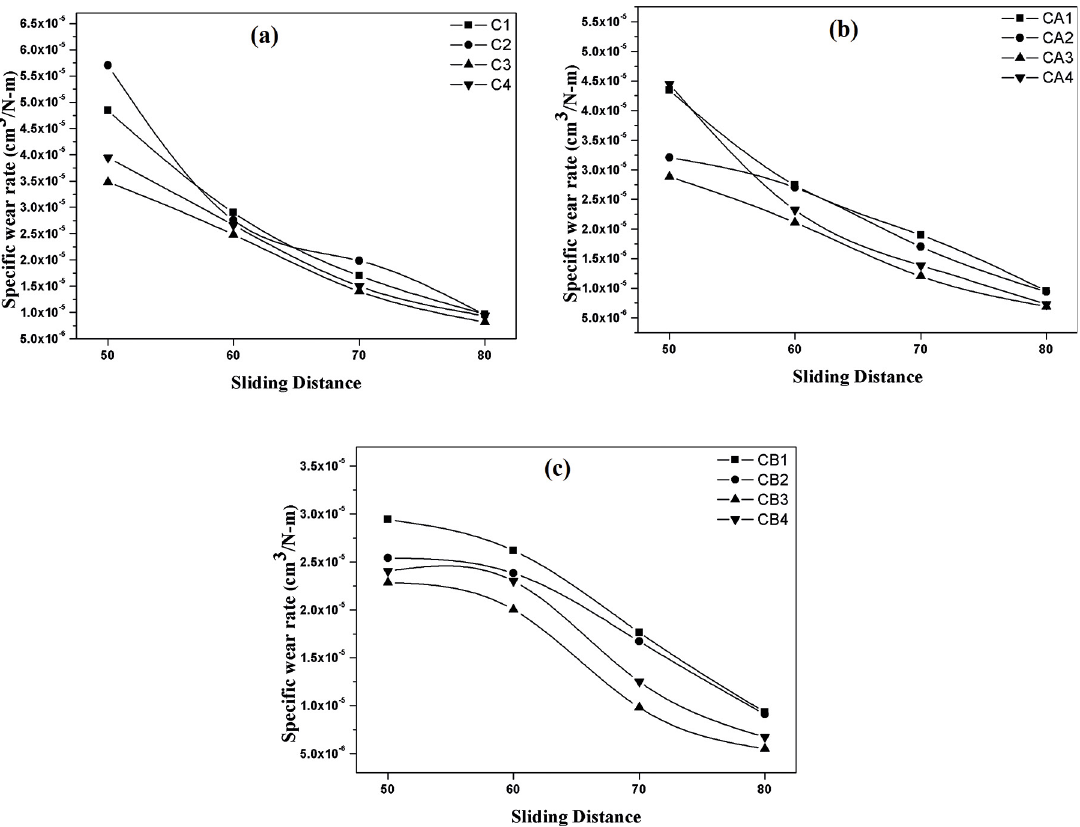
Figure 4. Effect of sliding distance on the specific wear rate of (a) Untreated (b) Alkali treated (c) Benzoyl chloride treated jute fiber-epoxy composites. (constant normal load: 20 N and abrasive size: 300 mm).